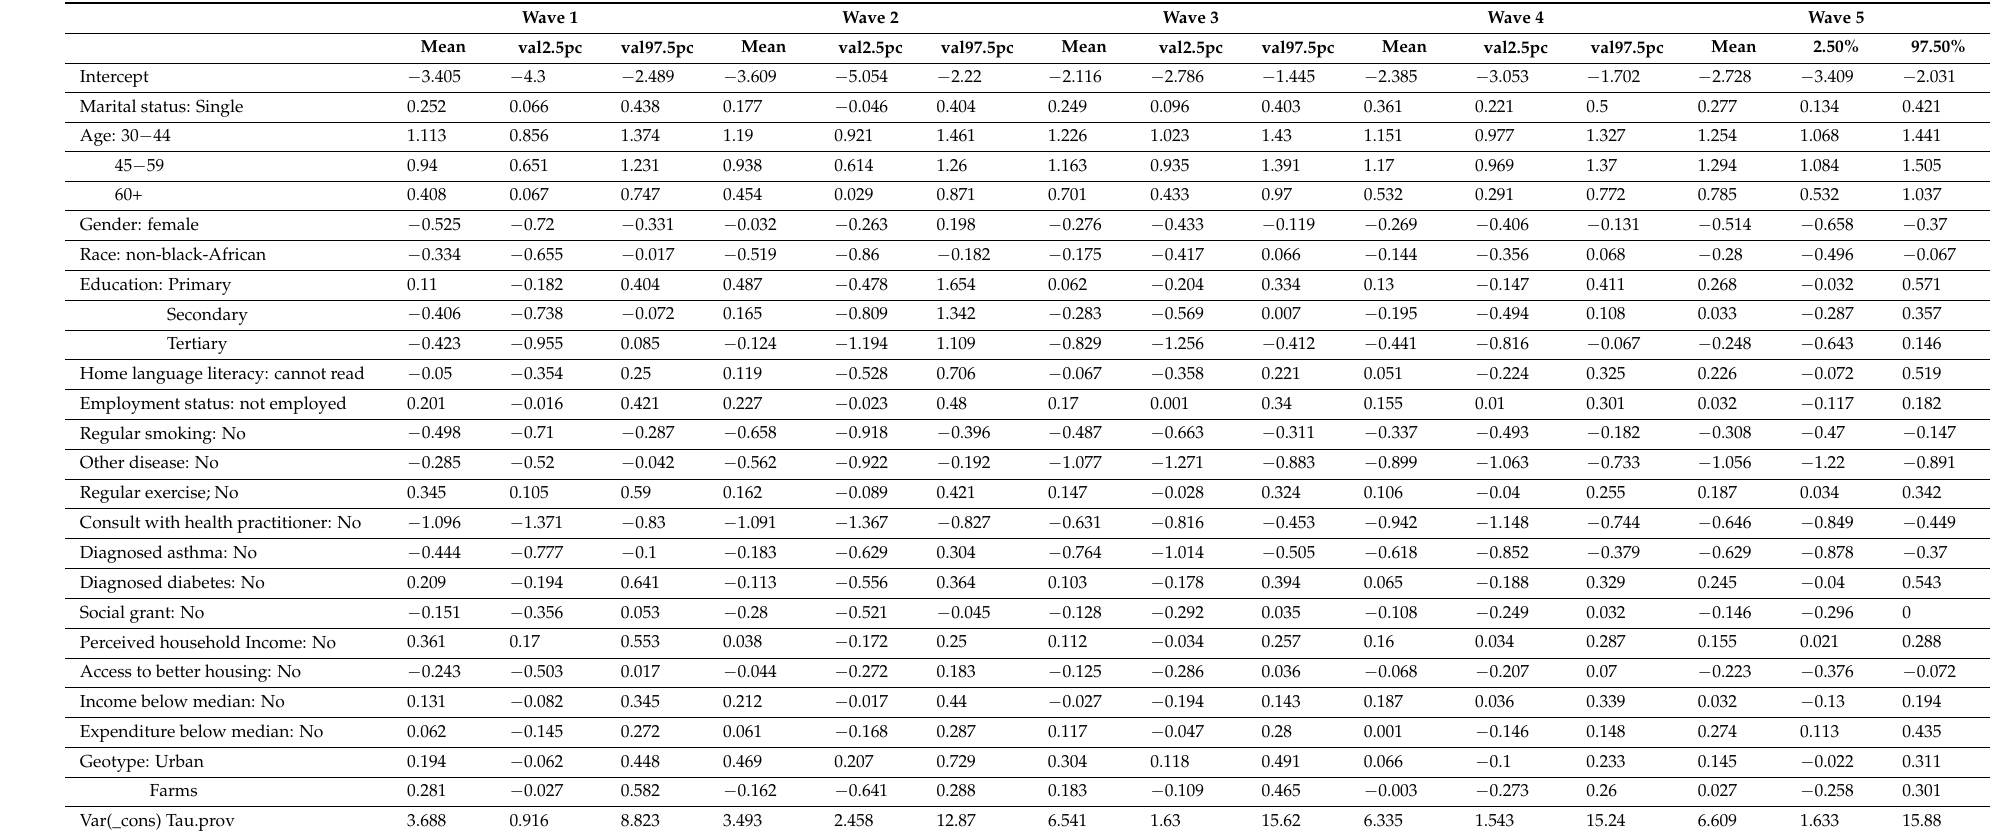
Table A2. Waves 1 to 5 Bayesian